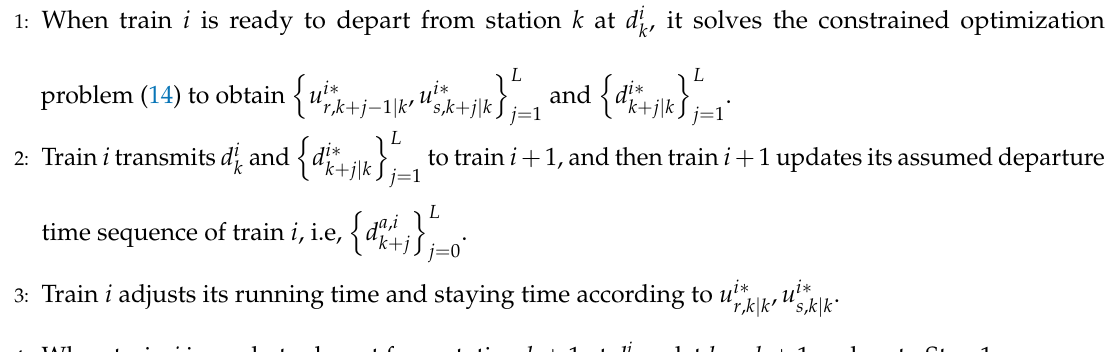
Algorithm 1 DMPC algorithm for energy-saving train